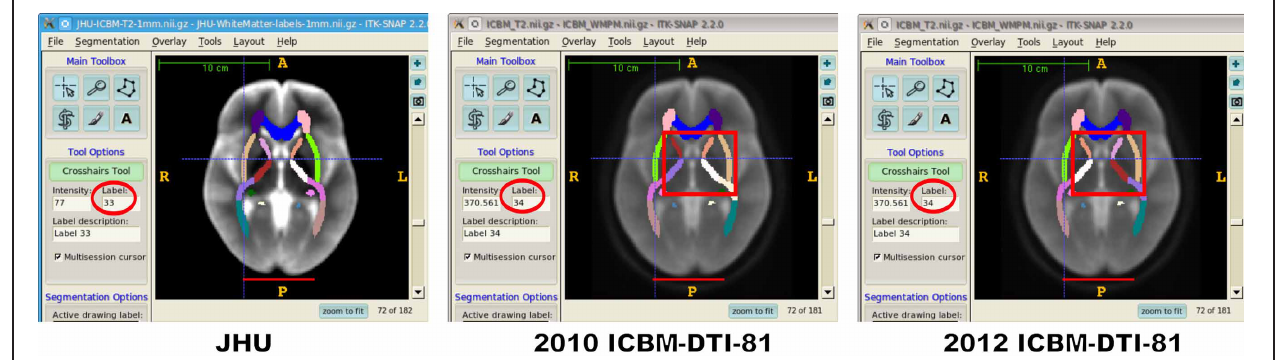
table). The cross-hair cursor points to the same point in the right brain hemisphere (according to image coordinates) in all three atlases. The label under the cursor (circled in red) correctly denotes “EC-R” (#33) in the JHU label map, but “EC-L” (#34) in the 2010 ICBM-DTI-81 label map. In